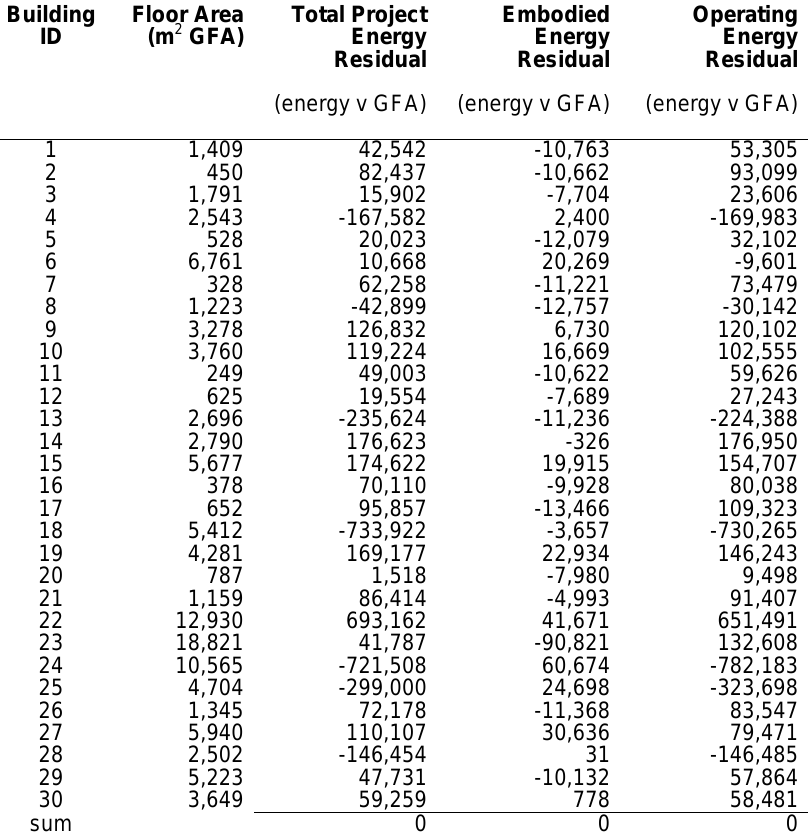
Table 4: Case study energy residual